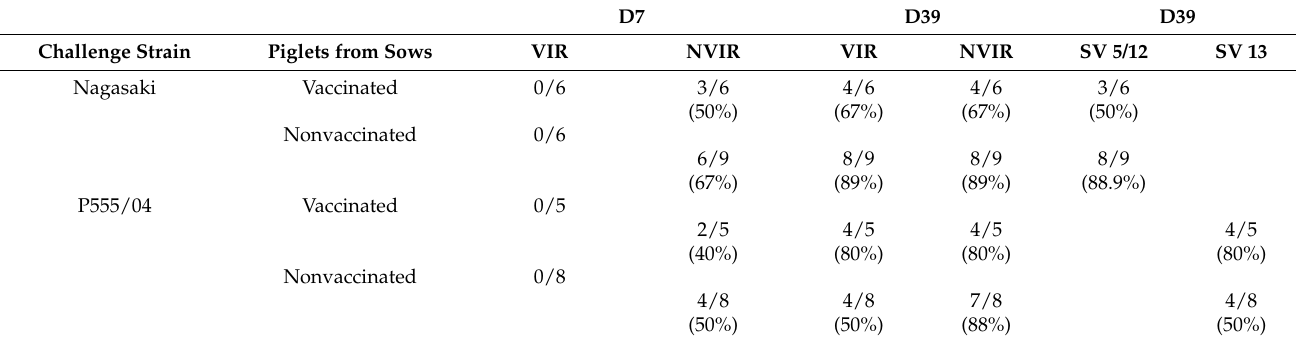
Table 7. Detection of virulent (VIR) and nonvirulent (NVIR) Glaesserella parasuis strains in nasal swabs by LS-PCR and serovar PCR at different times in piglets born to vaccinated or nonvaccinated sows after an intranasal challenge with two virulent strains of G. parasuis (serovar SV5 Nagasaki and serovar SV13 P555/04) at 22 days of